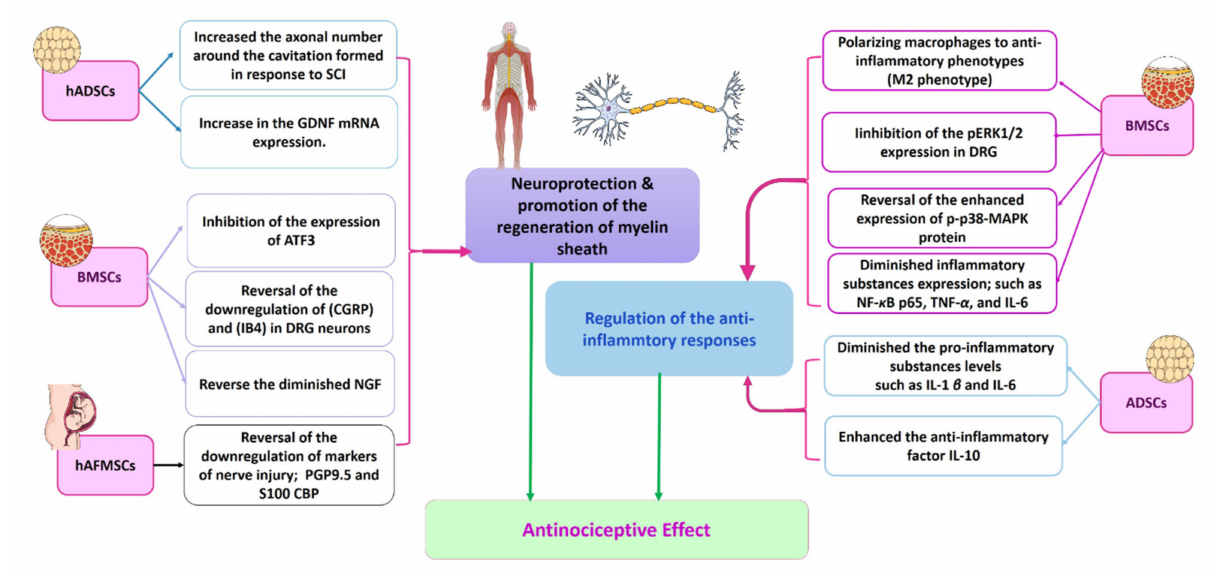
Figure 5. Proposed mechanisms involved in peripheral NP alleviation by stem cell therapy. Based on previous research, it is clear that there are two main mechanisms by which the different types of stem cells counteract hyperalgesia. These mechanisms are regulation of the anti-inflammatory responses and neuroprotection and promotion of the regeneration of myelin sheath. BMSCs act via the two mechanisms through a variety of pathways that varied according to the methodologies of the previous research. The ADSCs seem to regulate the anti-inflammatory responses, whilst the hADSCs work through the neuroprotective mechanism. The hAFMSCs act mainly via neuroprotection [31,233,234]. ADSCs: adipose-derived stem cells; ATF3: activating transcription factor 3; BMSCs: bone marrow derived stem cells; CGRP: calcitonin gene-related peptide CREB: cAMP response